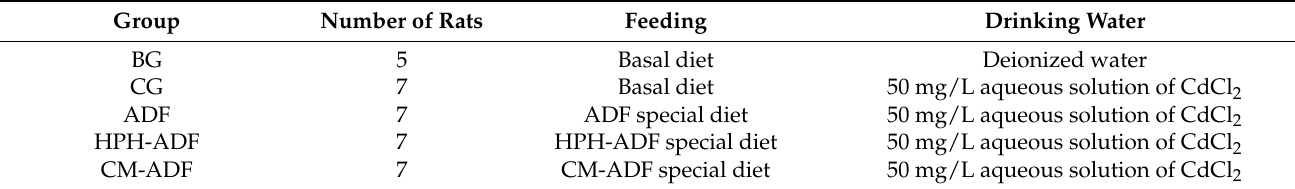
Table 1. Experimental rat grouping and